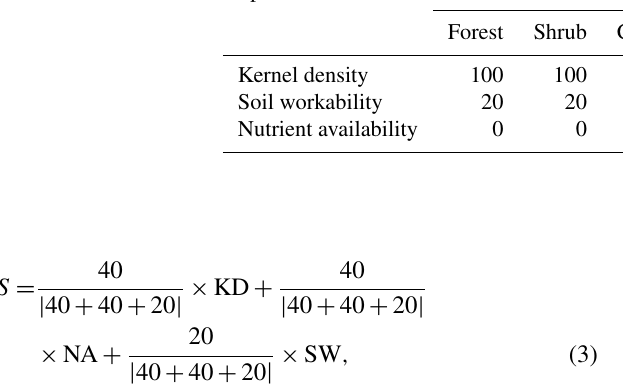
Table 6. User-defined spatial constrains. Spatial constrains Final land types (FLTs) for downscaling Forest Shrub Grass